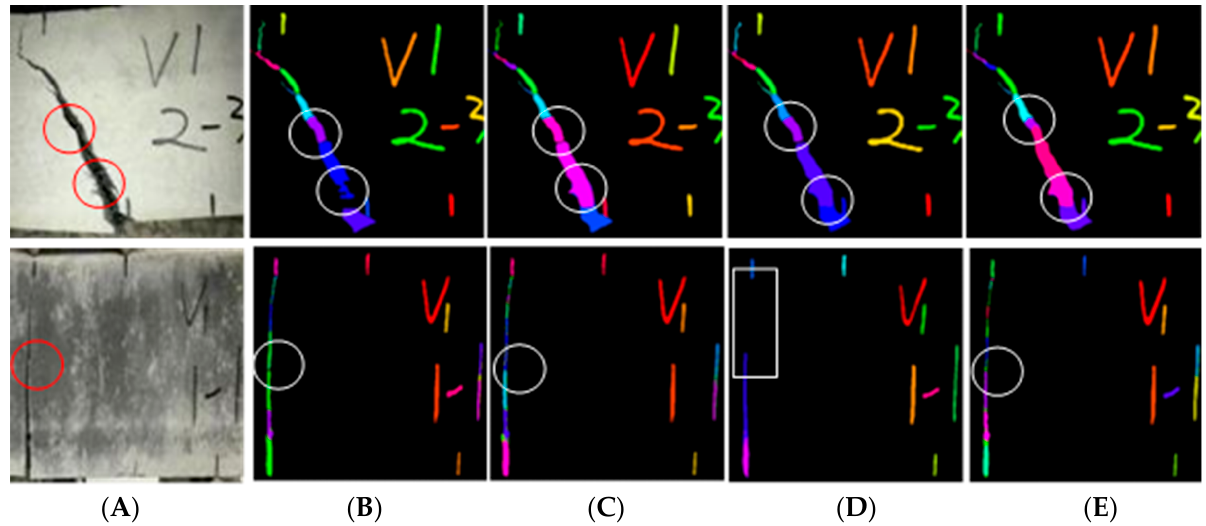
Figure 12. Comparison of detection targets. ( A ) Original image; ( B ) R-CNN; ( C ) E-R-CNN; ( D ) T1-R-CNN; ( E ) T-R-CNN.